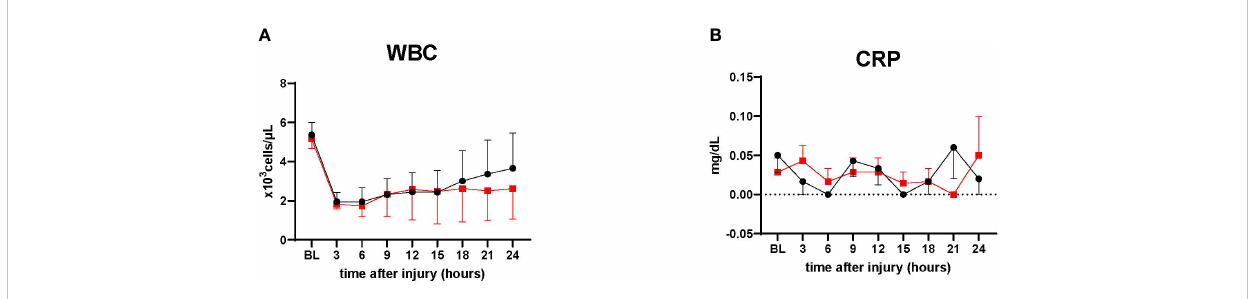
FIGURE 7 In fl ammatory marker. (A) White blood cells count (WBC), ● Control (n=4 at 0-24 h), ■ Treatment (n=4 at 0-24 h). (B) C-reactive protein measurement. ● Control (n=7 at 0-18 h and 6 at 19-24 h), ■ Treatment (n=7 at 0-16 h and 6 at 17-24 h). WBC in the treatment tended to be lower than the control after 18 h. CRP showed relatively low in both groups, with no signi fi cant differences. Data are expressed as mean ±